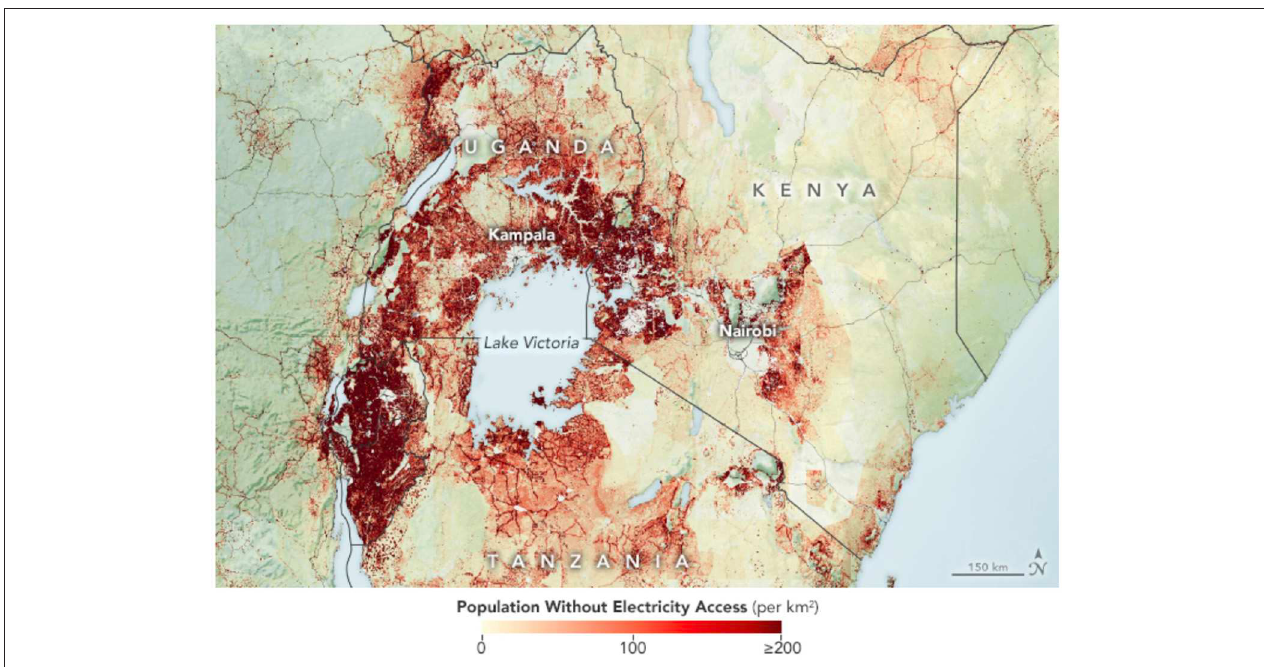
FIGURE 4 | Estimate of the number of people without access to electricity in East Africa using data from the VIIRS instrument on the NOAA-NASA Suomi NPP satellite, land cover type data from NASA’s MODIS instrument, and data from Oak Ridge National Laboratory’s LandScan. [Credit: NASA Earth Observatory image by Lauren Dauphin, using data from Falchetta et al. (2019, 2020a) (NASA Earth Observatory,